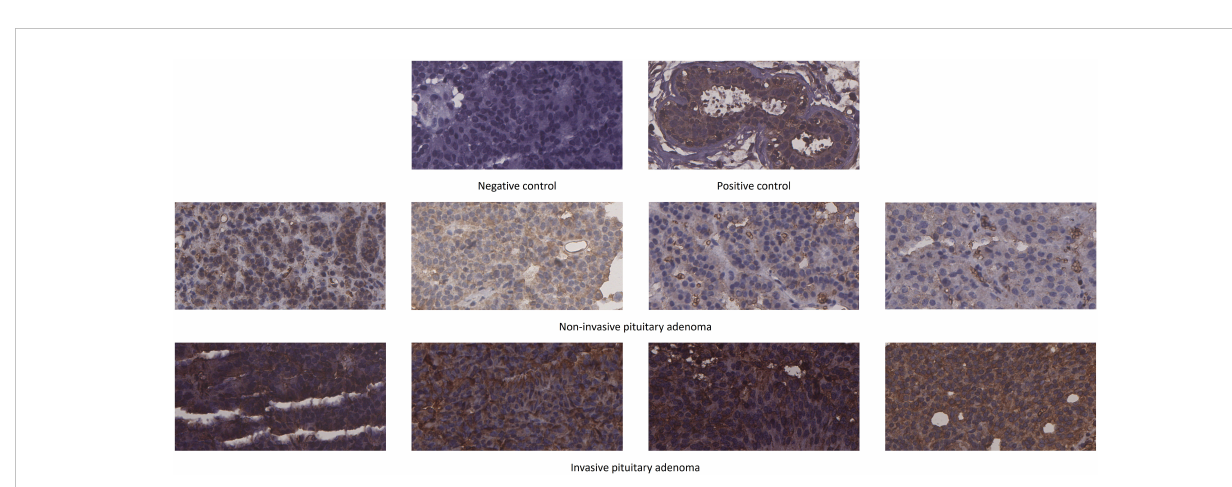
FIGURE 9 Immunohistochemical staining of SLC2A1 in non-invasive and invasive pituitary